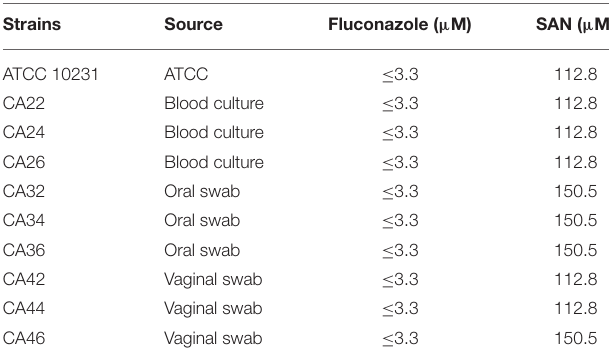
TABLE 1 | Minimum inhibitory concentration (MIC) values ( µ M) of sanguinarine against C. albicans and clinical isolates.